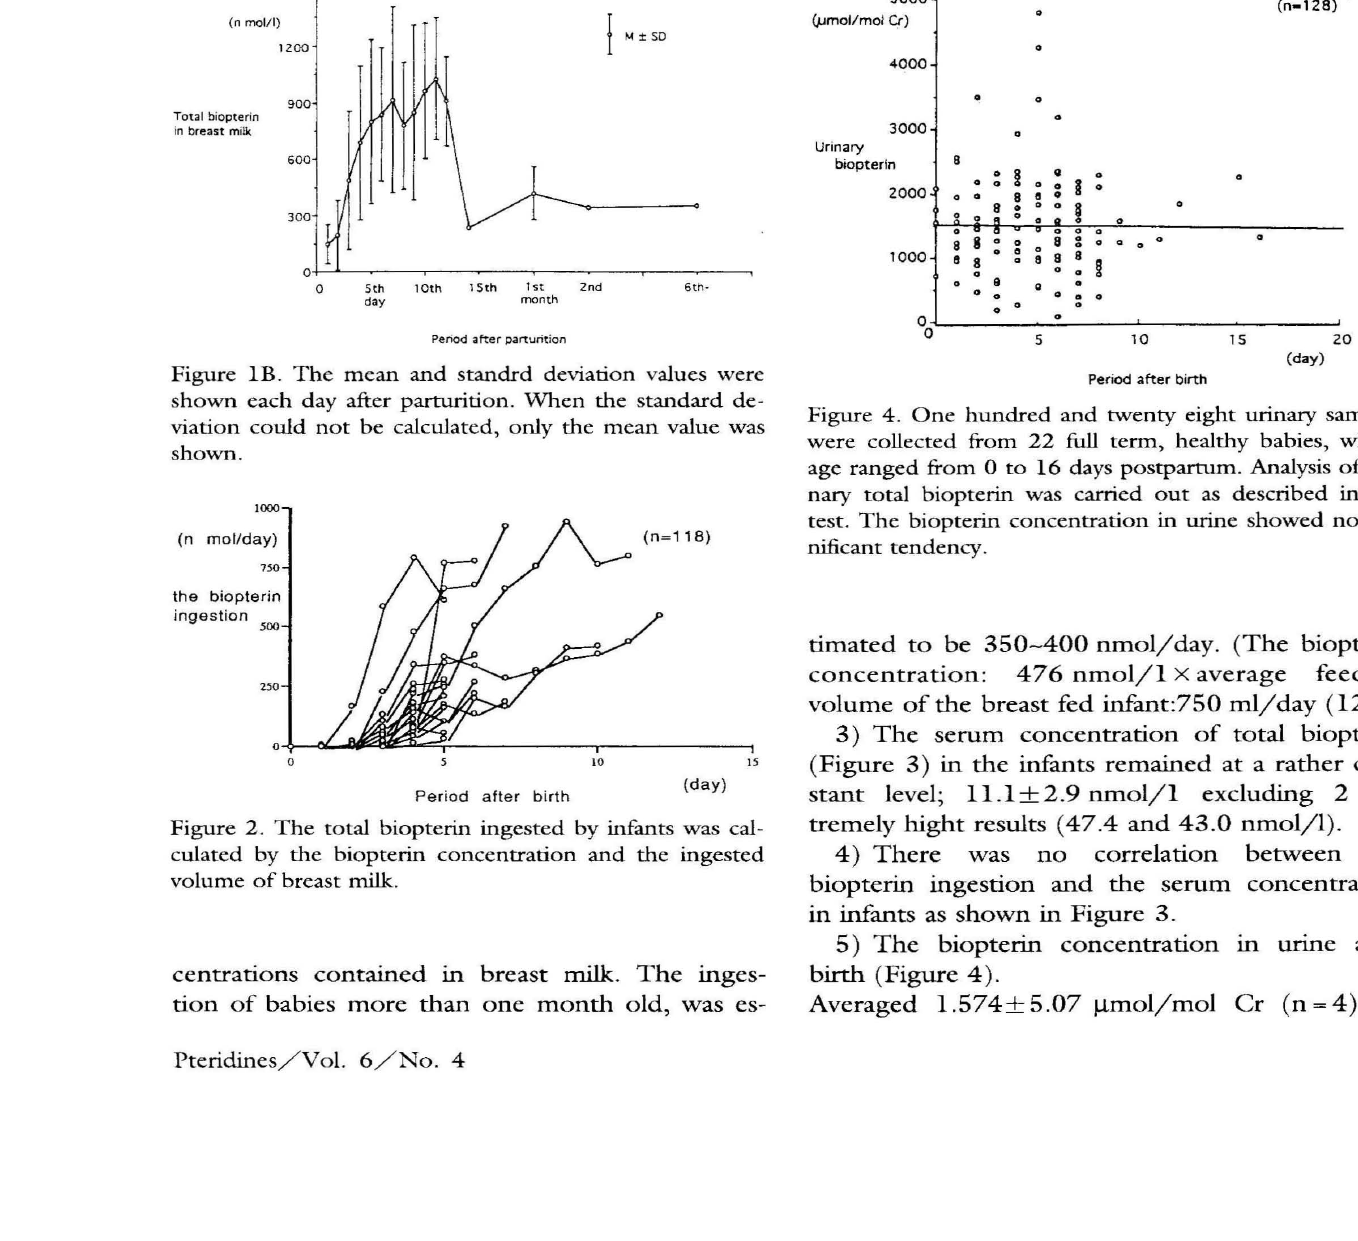
correlation biopterin ingestion and the serum concentration in infants as shown in Figure